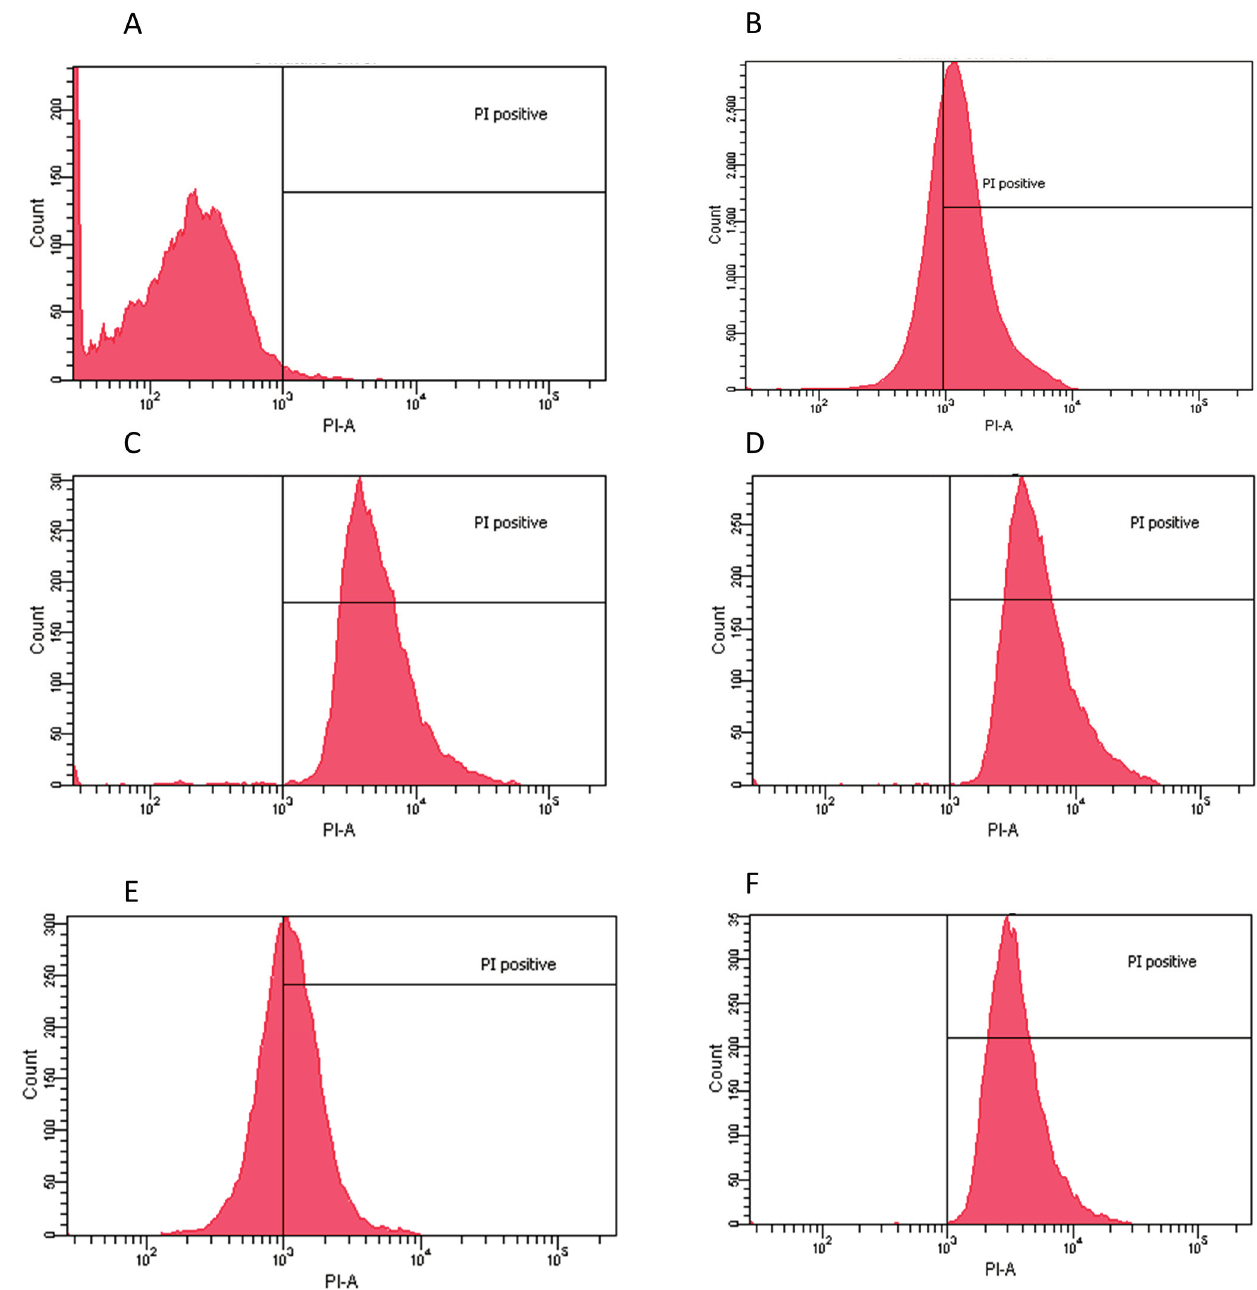
Figure 4. Flow cytometry histograms derived from scatter plots showing fluorescence of live (<103) or dead (>103) of S. mutans stained with PI post 24 h incubation with controls or extracts. X-axis corresponds to the PI positive marked microorganisms and Y-axis to the total cell count. ( A ) S. mutans sample PI negative control, 99.8% viability; ( B ) S. mutans incubated for 30 min with ethanol 70% PI positive control 30.6% viability; ( C ) water dry leaf non-boiled extract 1 μ g/mL, 1.5% viability; ( D ) Acetone 4 μ g/mL, 0.5% viability; and ( E ) Petroleum ether 1 μ g/mL, 41.6% viability; ( F ) Chloroform 3.5 μ g/mL, 0.3%